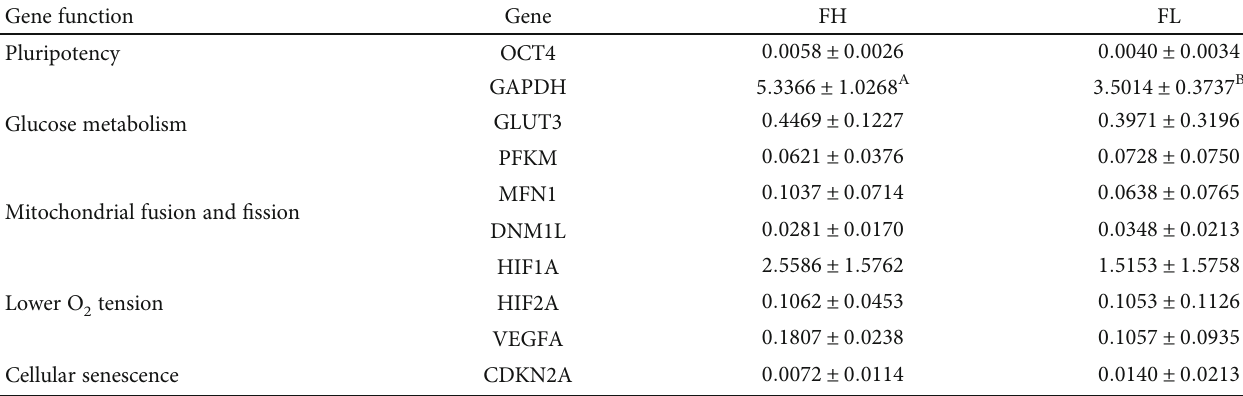
(FH) to those cultured in 5% O 2